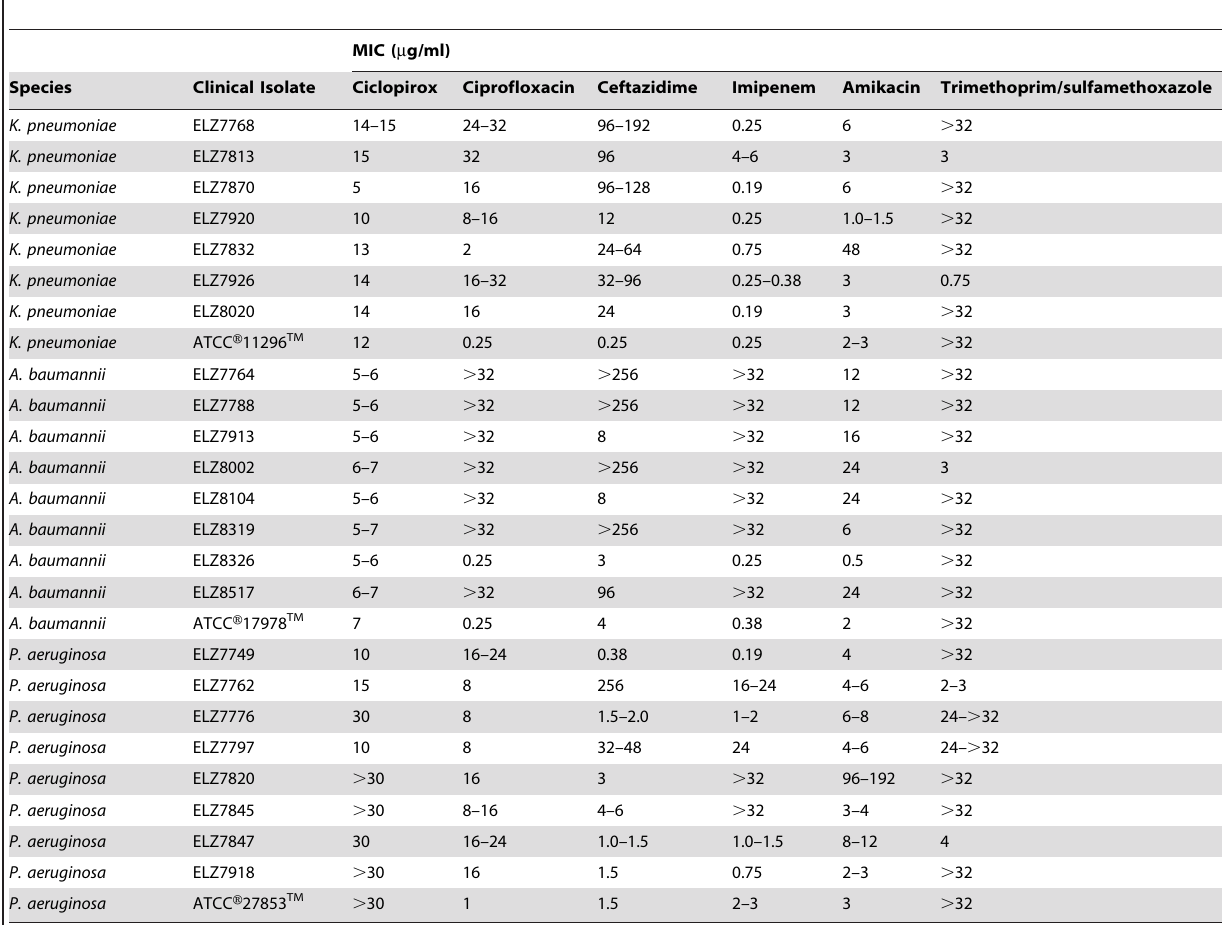
Table 1. Ciclopirox and other Antibiotic MICs in K. pneumoniae , A. baumannii , and P. aeruginosa clinical